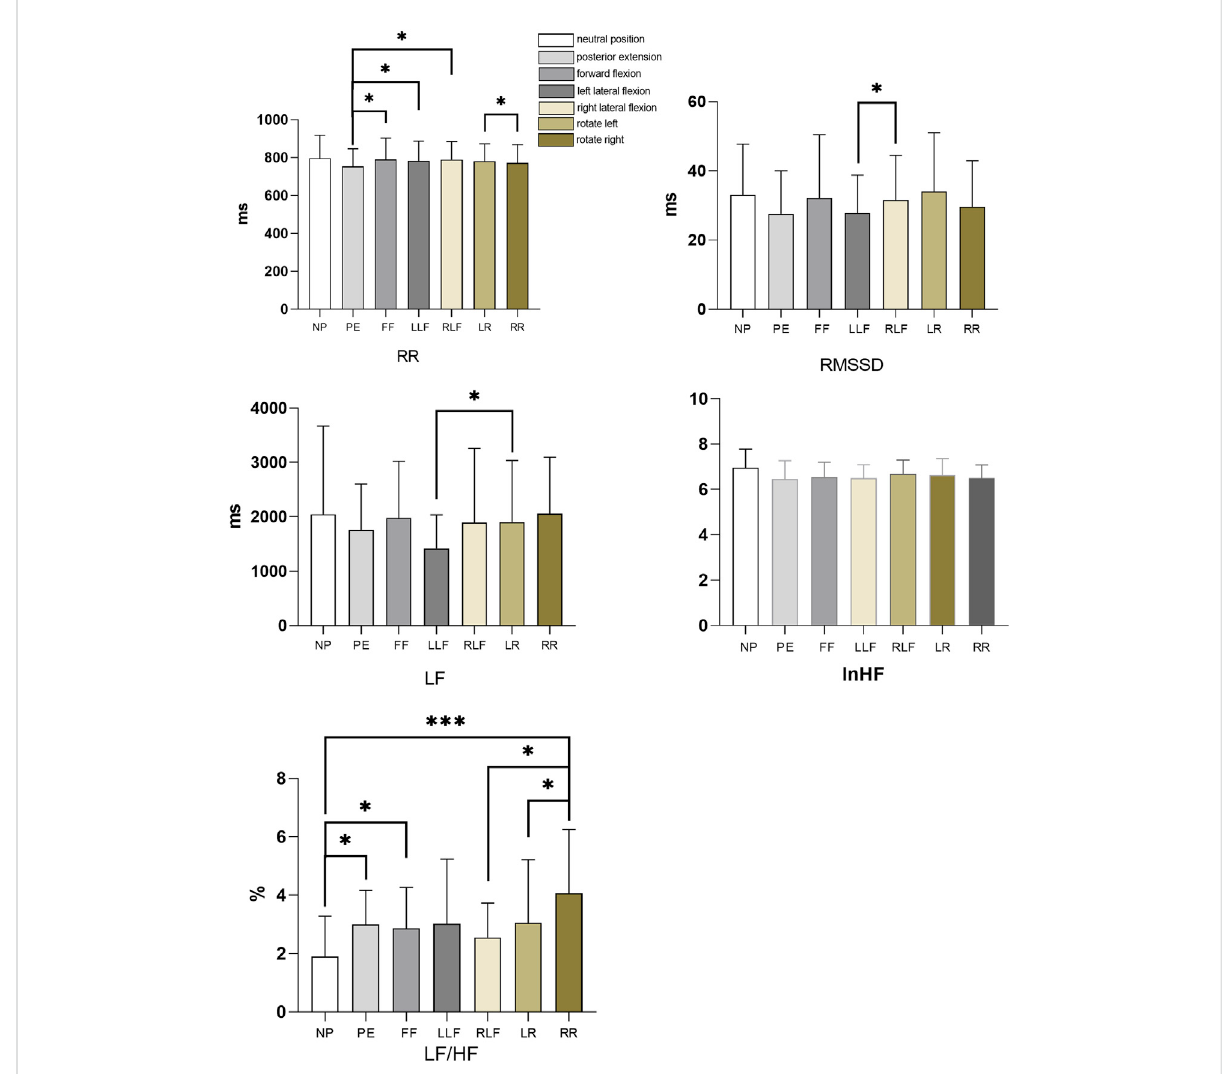
FIGURE 5 Histogram of heart rate variability (RR, RMSSD, LF, lnHF, LF/HF) for seven postures. NP stands for neutral, PE stands for posterior extension, FF stands for forward fl exion, LLF stands for left lateral fl exion, RLF stands for right lateral fl exion, LR stands for left rotation, RR stands for right rotation. * p < 0.05, *** p <